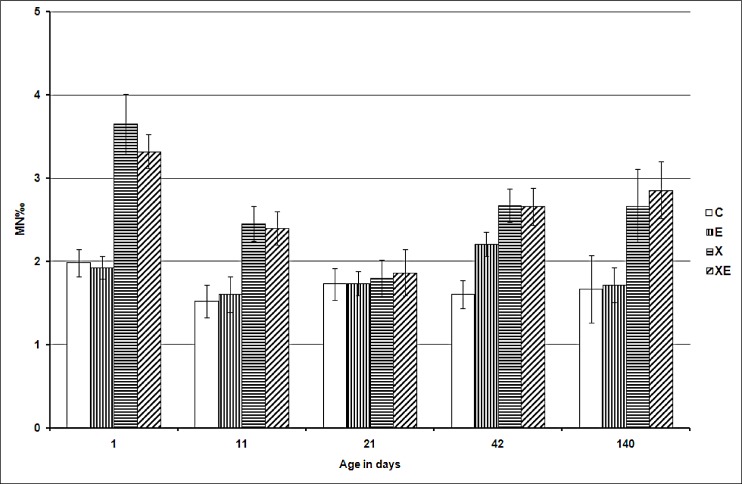
Micronucleus frequencies in peripheral blood erythrocytes.The number of animals in each group is reported inside the histogram columns. Bars represent standard error. Significance compared to C: * p<0.05; ** p<0.01; *** p<0.001.